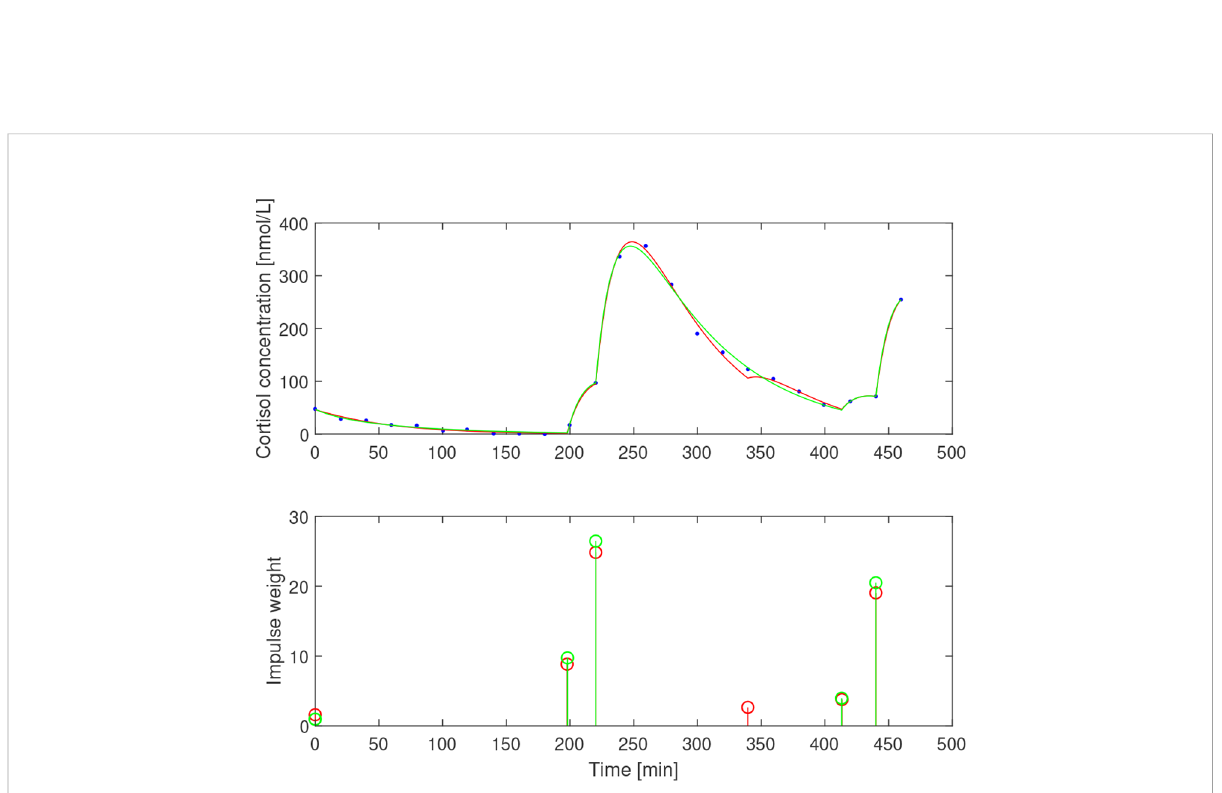
FIGURE 13 Simulated cortisol concentration (top) together with measured values (blue dots) and impulse estimates (bottom) from estimation assuming b 1 =0.05 min − 1 (red) and b 1 =0.065 min − 1 (green) for